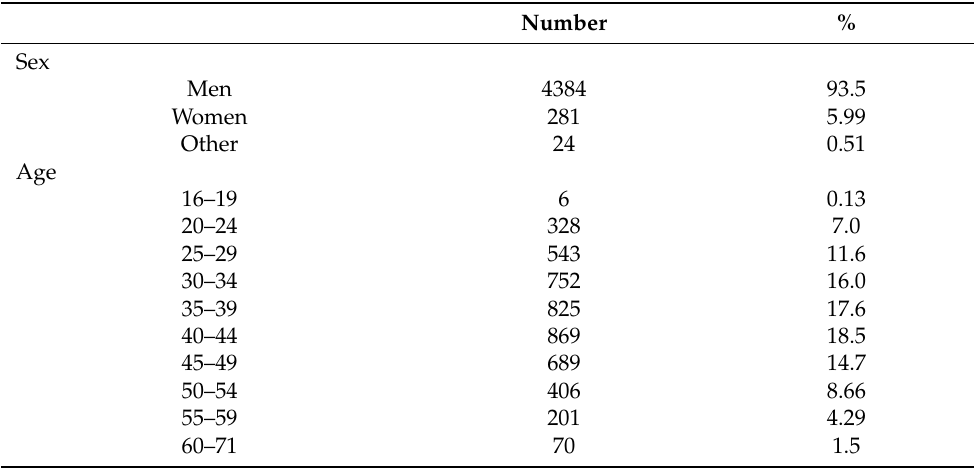
Table 1. Demographic characteristics of study subjects ( n = 4689).